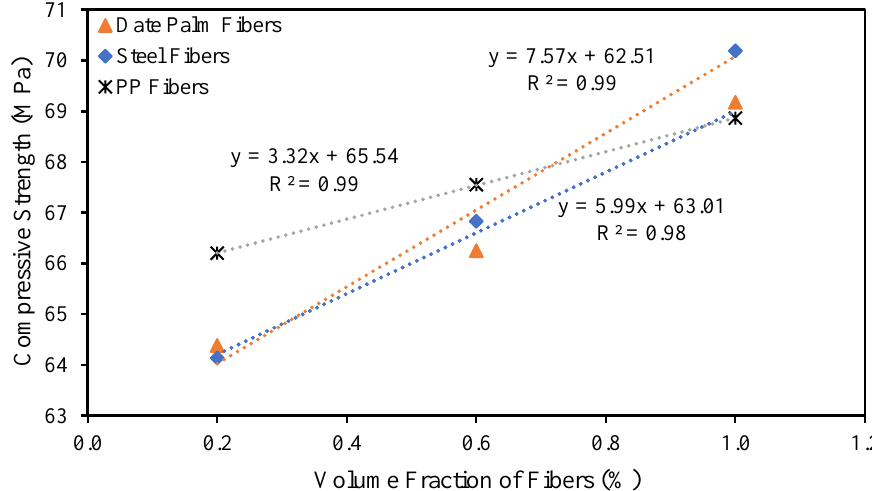
Figure 5. Relationship between the compressive strength and fractions of different fibers.